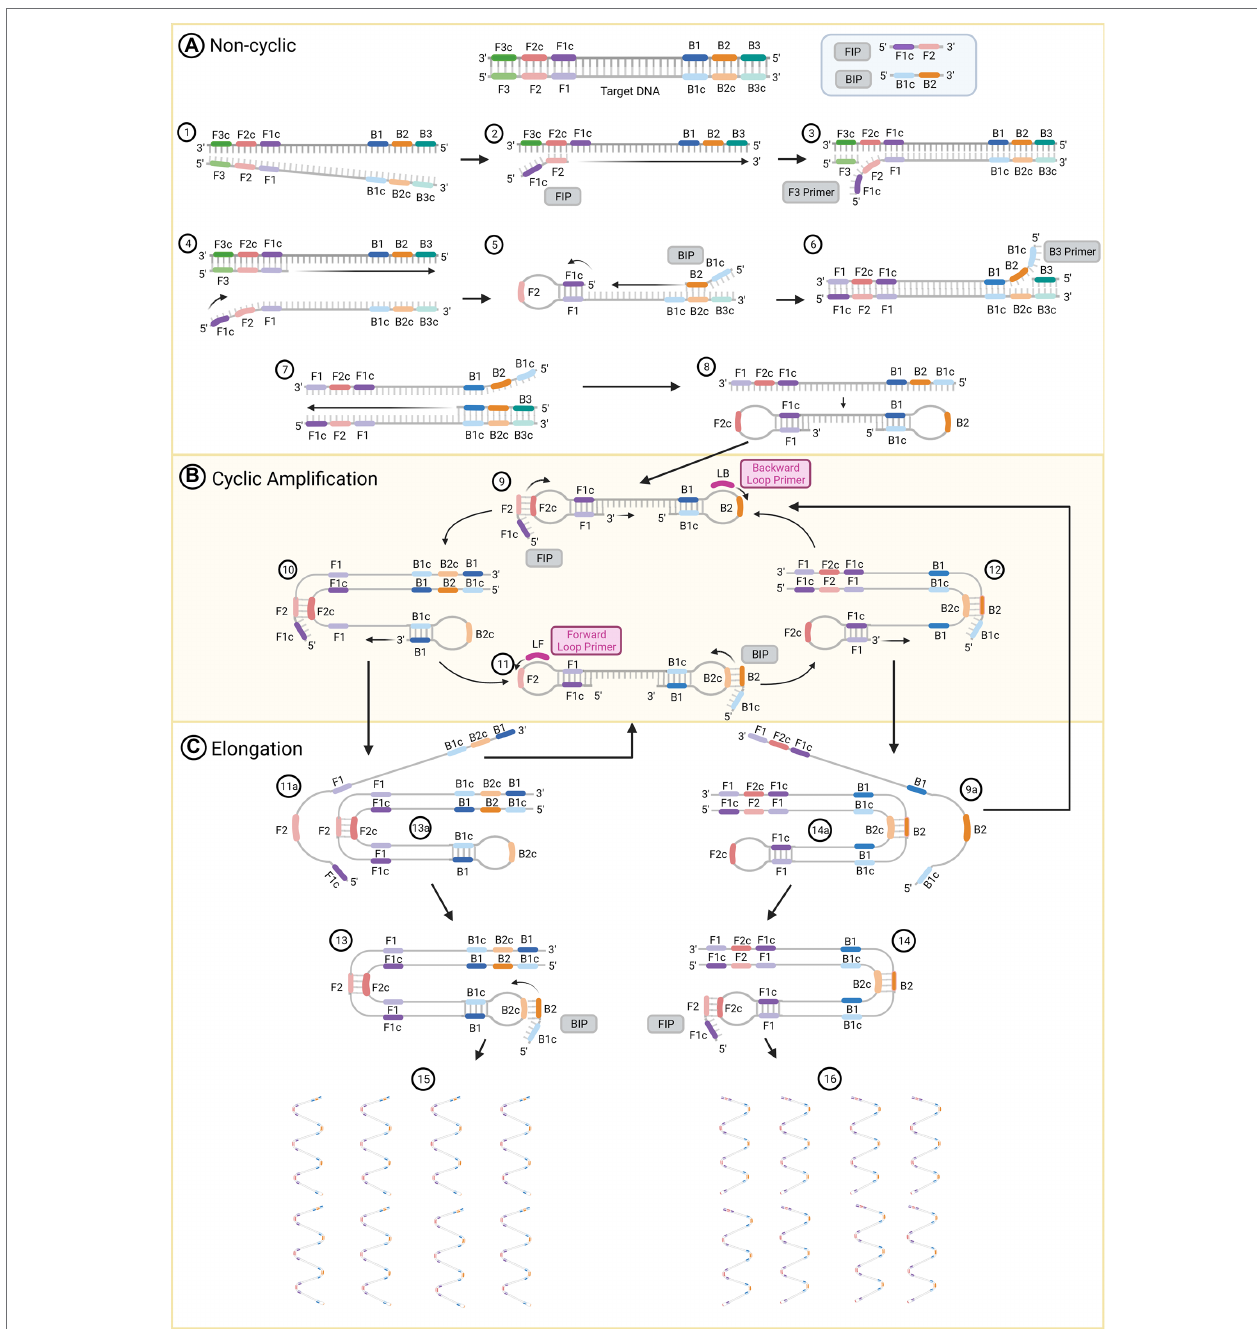
FIGURE 1 | The loop-mediated isothermal amplification (LAMP) technique amplification process. (A) Non-cyclic steps that produce a DNA strand with two loops at their 5 ’ and 3 ’ ends. (B) Cyclic amplification steps and (C) elongation. Figure was created with